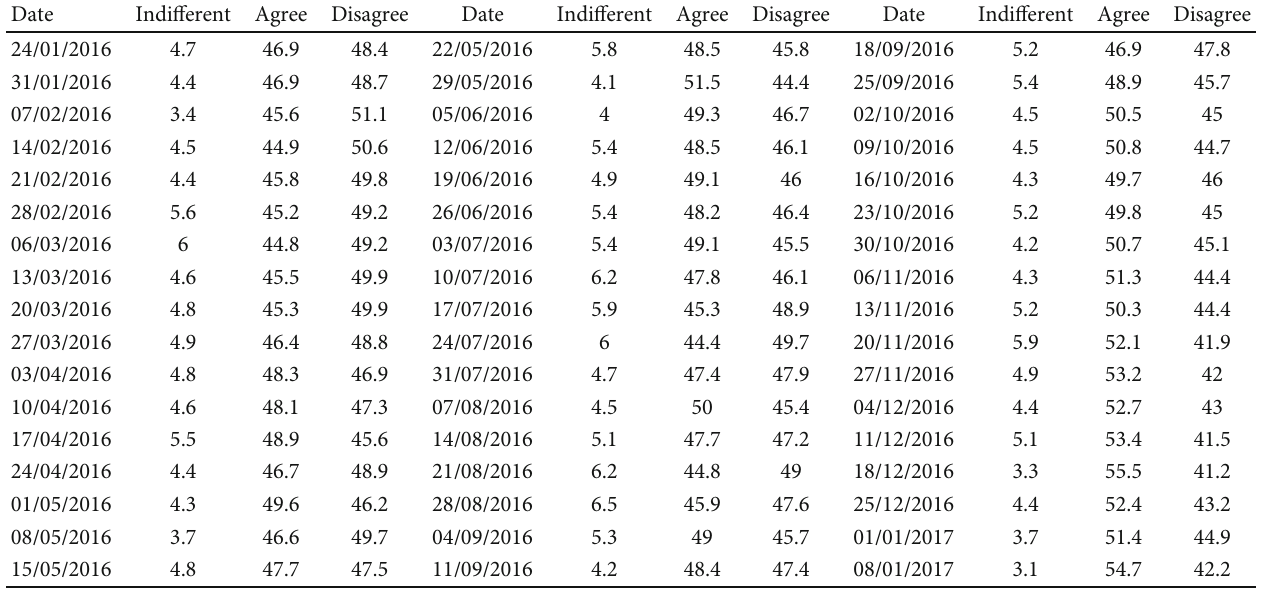
Table 2: Data of the fi rst Poll from [14], where the fi rst week is 17/01/2016 with I = 3 : 7 , A = 45 : 3 , and D = 51 : 1